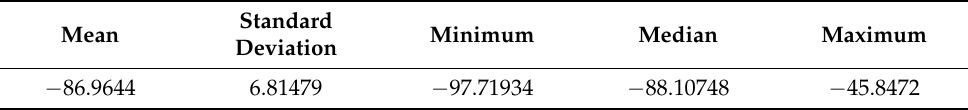
Figure 19. The interaction energy of the difenoconazole molecule onto Cell-X surface during MD. The results show that there are bonding sites on the polymer surface, the difenoconazole molecule fits well and interacts strongly with functional groups present at the bonding sites, and the interaction is strong and stable. The Langmuir Adsorption model also shows that the difenoconazole molecules are equally and homogeneously spread over the polymer surface. Table 1. Statistics for the interaction energy of the difenoconazole molecule onto Cell-X surface during MD.